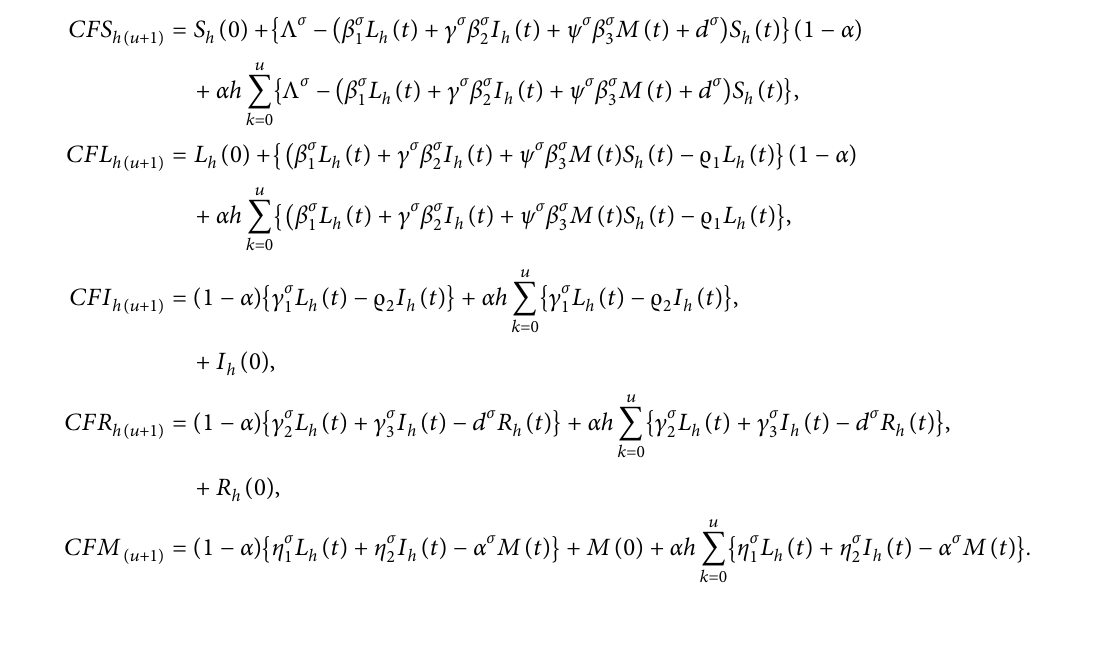
� 0 . 01, d � 0 . 01 c 3